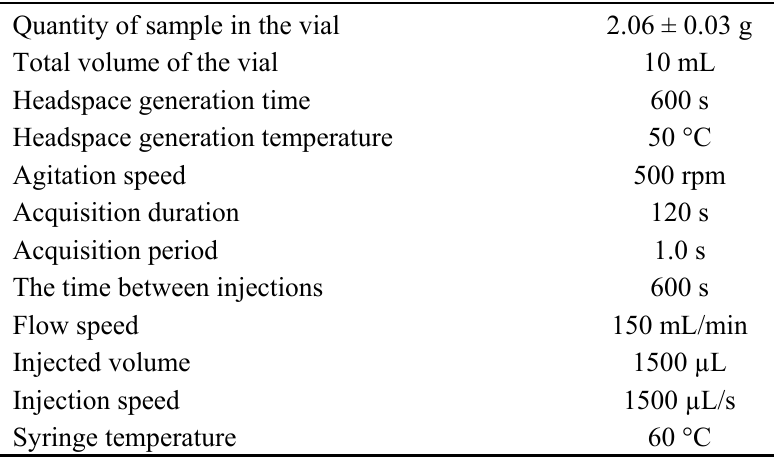
Table 2. Analytical conditions with the α FOX 4000